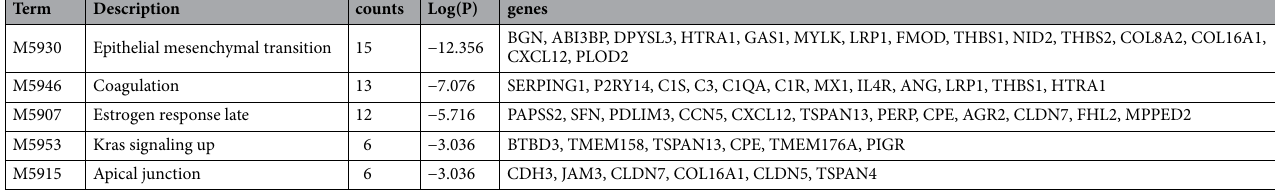
Table 3. Hallmark pathway enrichment analysis of DEGs.